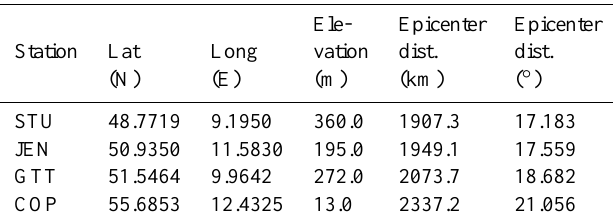
Table 2. Station coordinates associated with analogue seismo- grams used in the present study. Distances are given relative to the hypocenter location of the first earthquake according to Comninakis and Papazachos